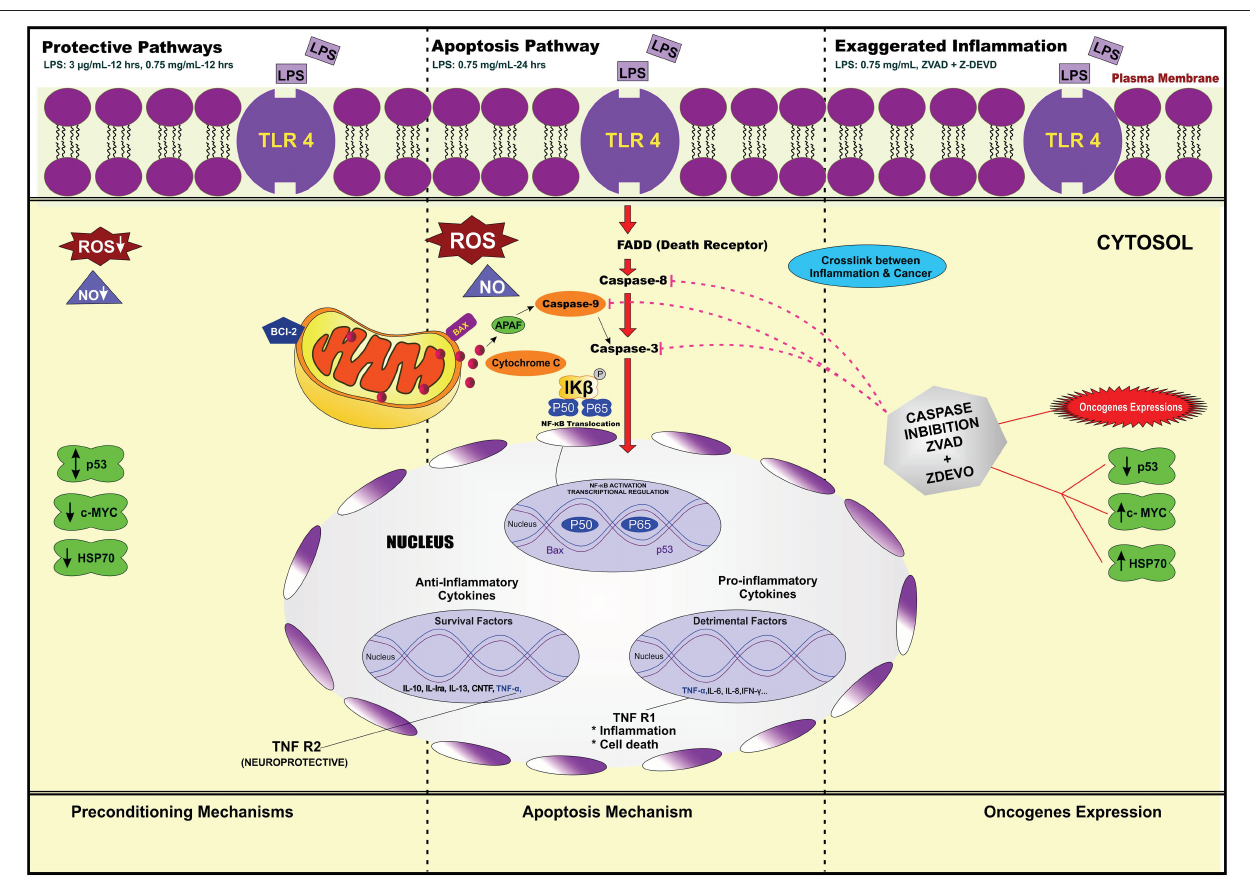
FIGURE 24 | Overview of the molecular signaling pathway. It is involved in LPS-preconditioned cells, LPS-induced cells, and LPS-induced cells incubated with caspase inhibitors via TLR4/caspase-3/NF- κ B signaling pathway in differentiated PC12 cells. Transcriptional factor NF- κ B and caspase-3 are associated with cytoprotection, inflammation, and activation of oncogene